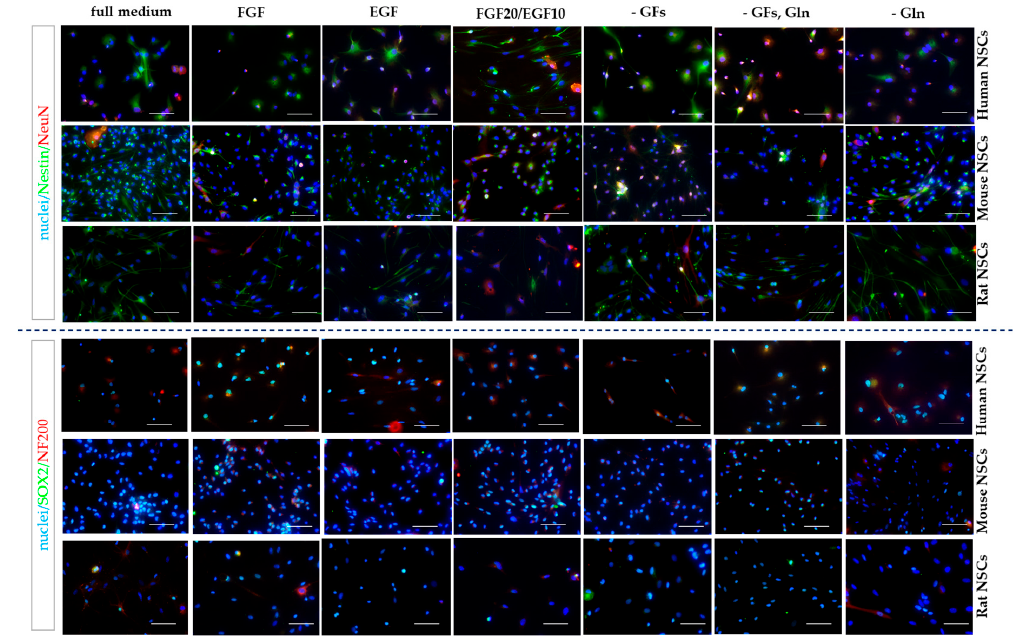
Figure 12. Neural differentiation of human, mouse, and rat NSCs in 2D conditions. Nestin, NeuN, SOX2 , and NF200 immunofluorescence analysis. Cell culture conditions: 5% O 2 , 5% CO 2 , 37 °C. Scale: 100 µm.